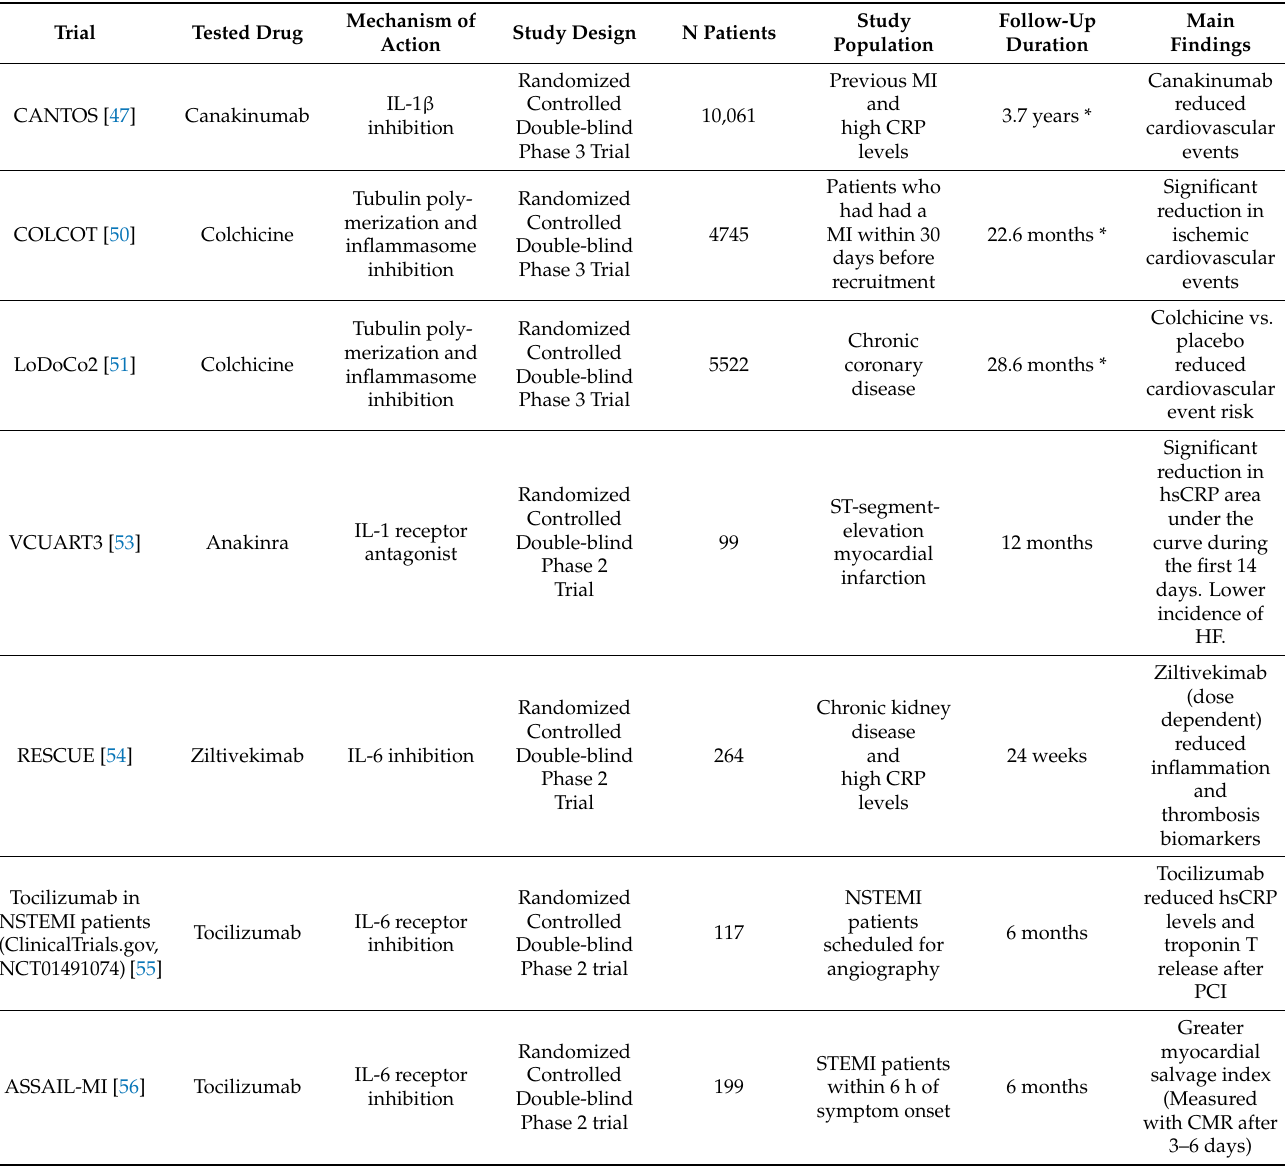
Table 1. Main clinical randomized, placebo-controlled, double-blind trials that investigated anti- inflammatory drugs to reduce atherosclerotic cardiovascular